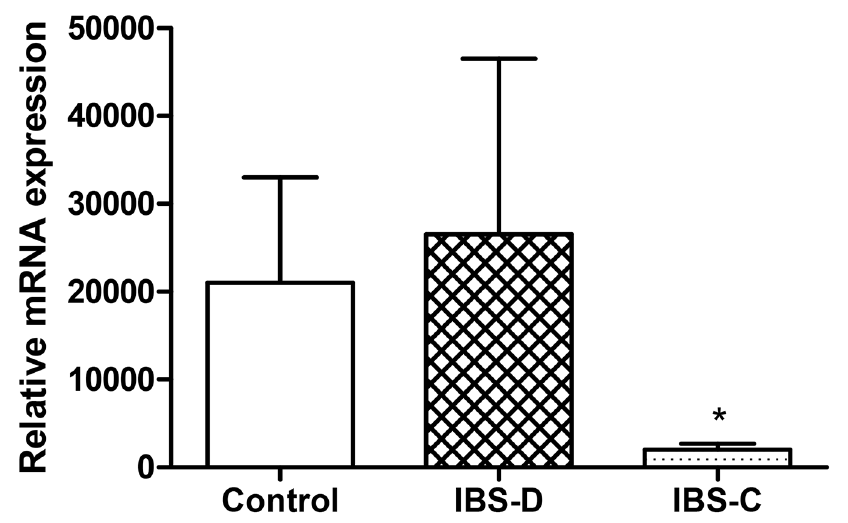
Figure 3. FAAH mRNA expression in colonic biopsies from patients with IBS-D and IBS-C vs. healthy controls. The results are shown as mean ±